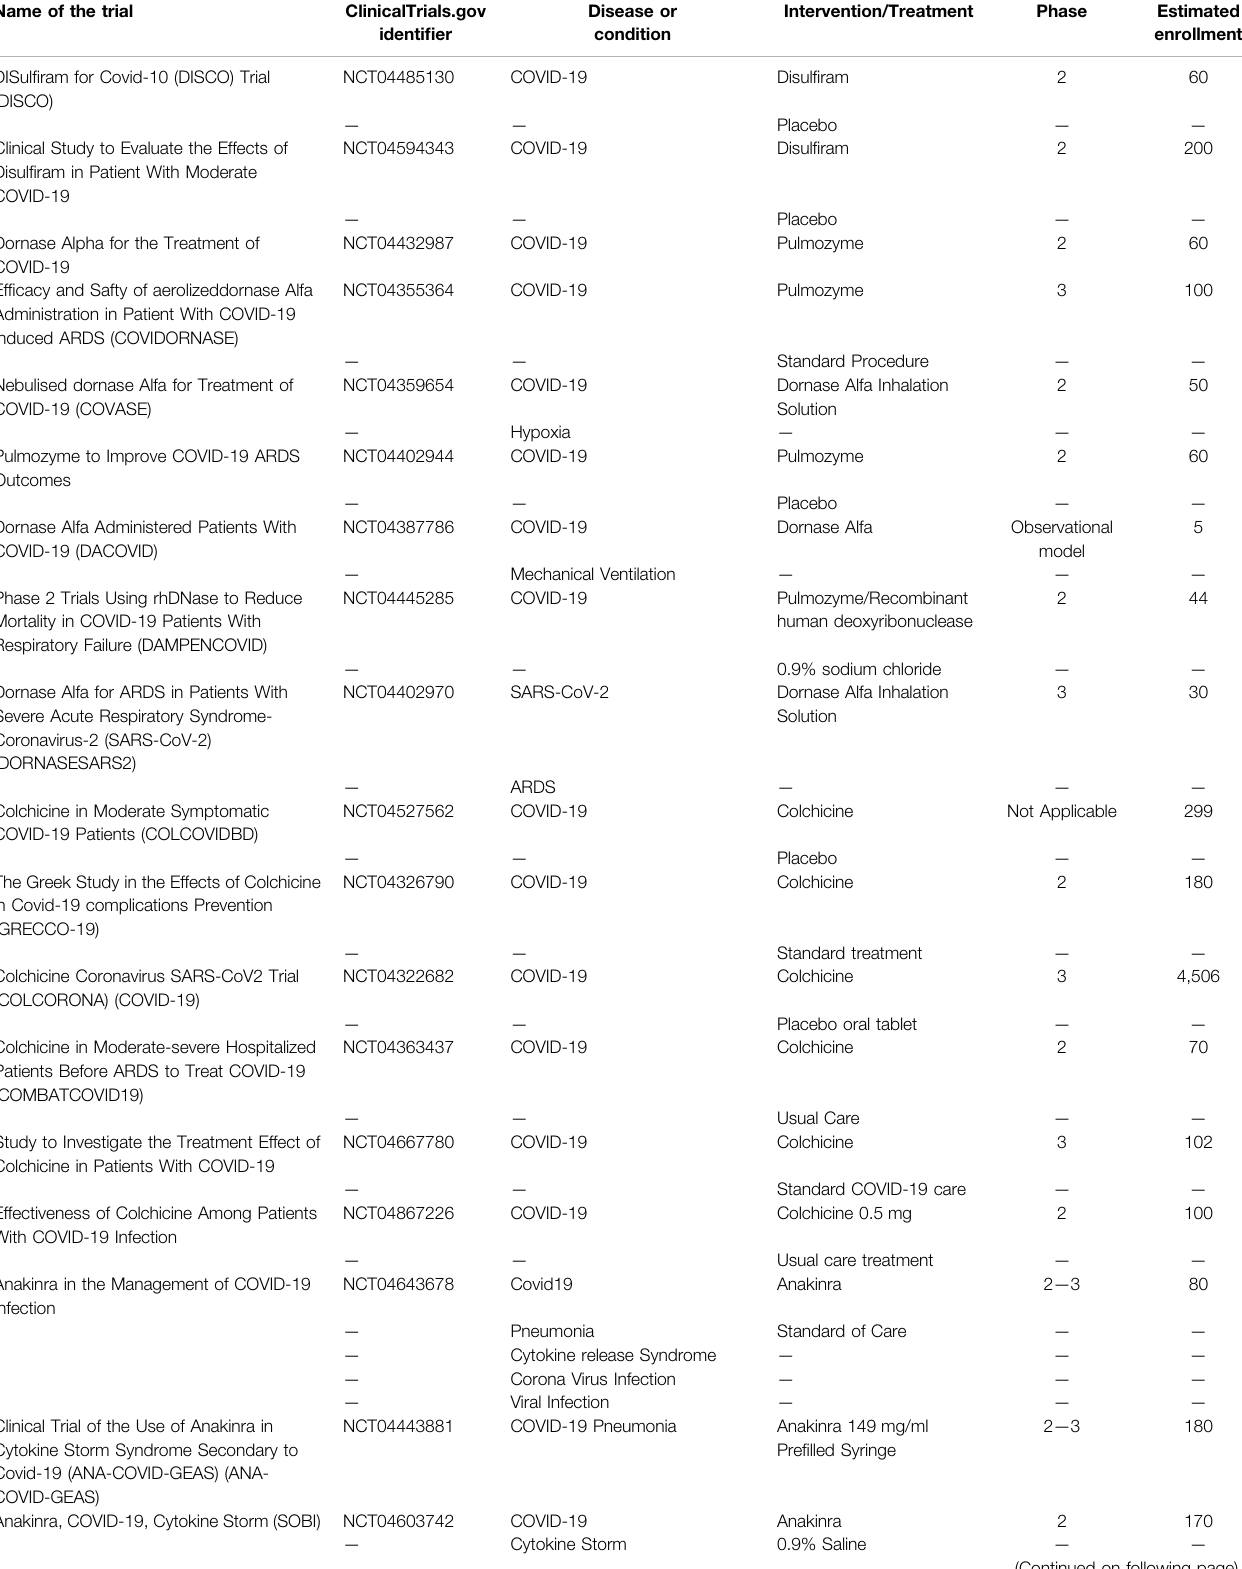
TABLE 1 | Table of different clinical trials on the mentioned